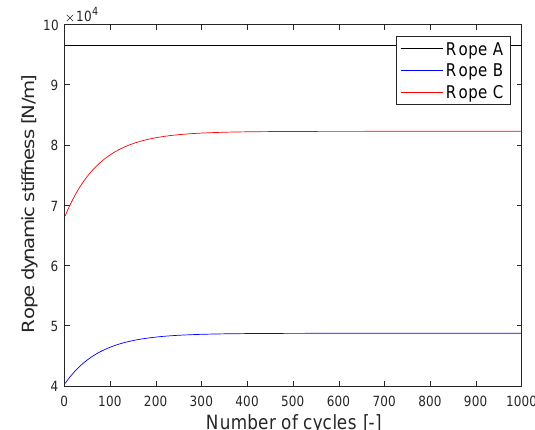
Figure 3: Influence of loading cycles on dynamic stiff- ness K d p for all ropes